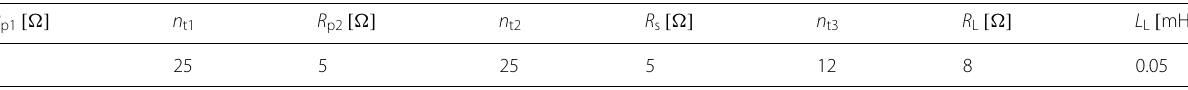
Table 2 Values of the parameters of the circuit in Fig. 10